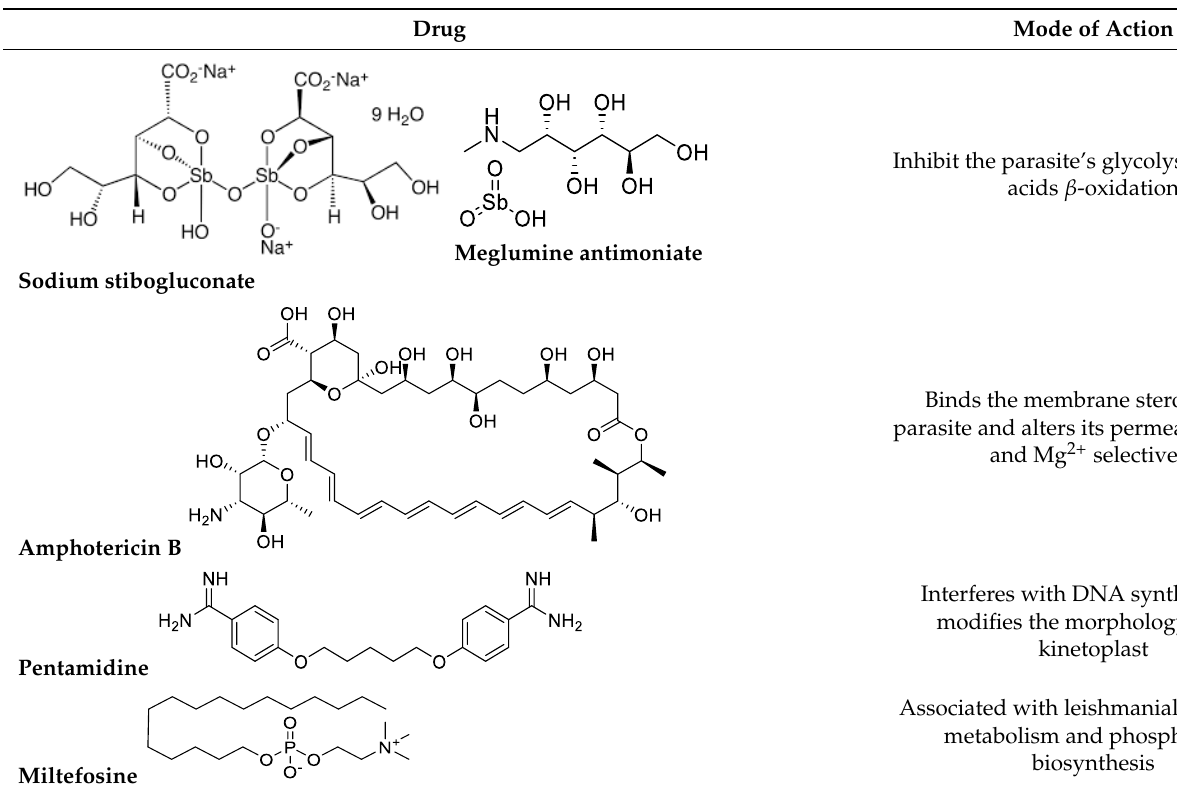
Table 1. Standard antileishmanial chemotherapeutic drugs and their suggested mode of antileishmanial effect. Drug Mode of Action